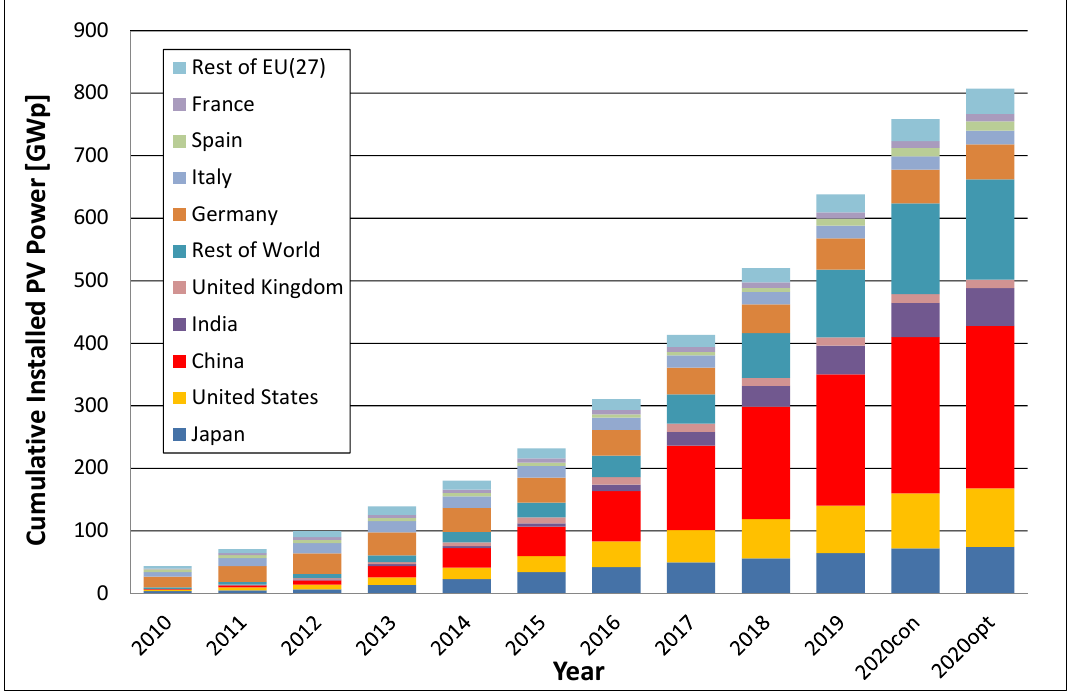
Figure 2. Annual photovoltaic installations from 2010 to 2020 (data source: [11–13] and own analysis).